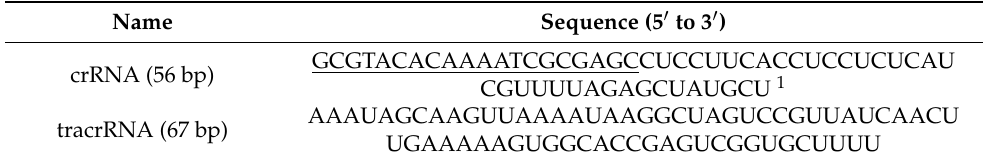
Table 1. RNA sequence